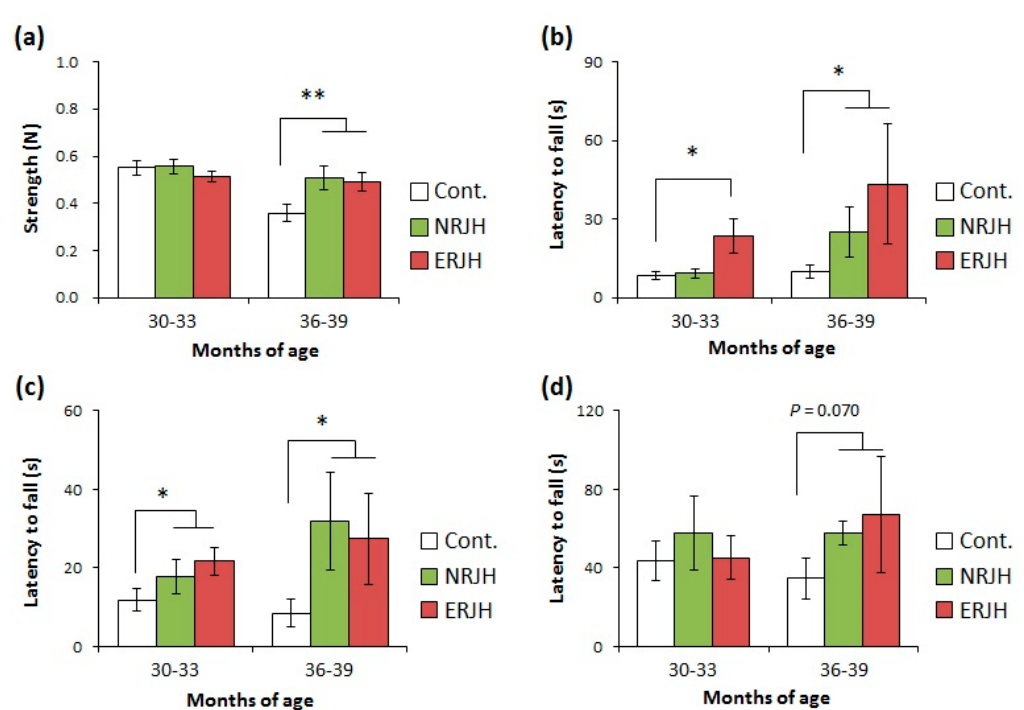
Figure 2. Royal jelly improved the age-related impairment of the motor function in genetically heterogeneous mice. The grip strength was measured by a spring gauge test ( a ) and a wire hang test ( b ). The locomotor activity was measured by a horizontal bar test ( c ) and an accelerated rotarod test ( d ). Data are shown as the mean ± standard error of mean (SEM) ( n = 14–18 at 30–33 months or n = 4–7 at 36–39 months). ** P < 0.01 and * P < 0.05 vs. 9–10 months.